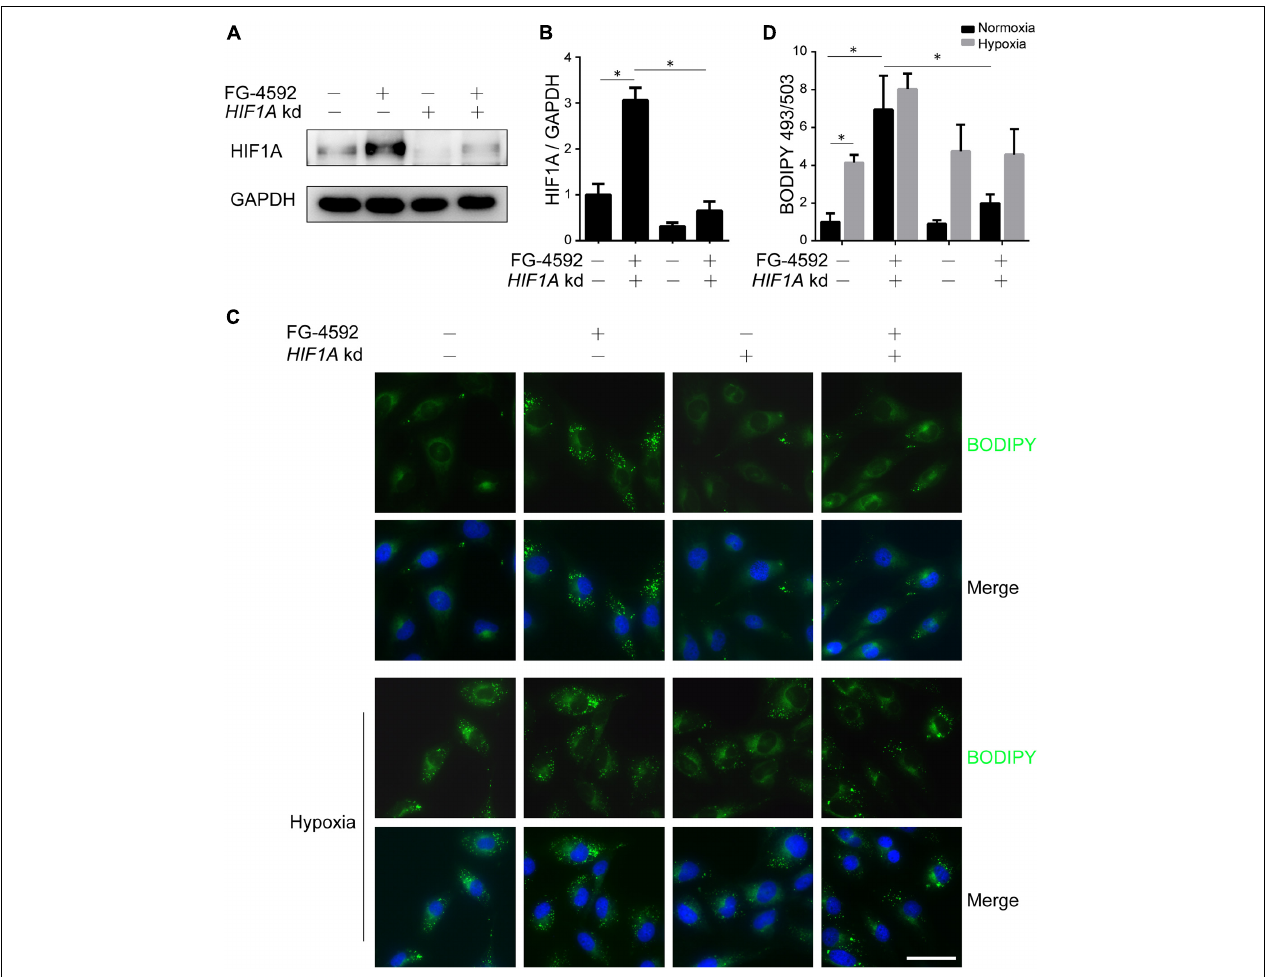
FIGURE 1 | HIF1 α activation leads to lipid accumulation in tubular cells. HK2 cells were treated or untreated with 50 µ M FG-4592 in serum-limited medium for 24 h. Representative immunoblots (A) and quantitative analysis (B) of HIF1 α in total cell lysates from HK2 cells. GAPDH was used as loading control. (C,D) Lipid droplets of HK2 cells were labeled by BODIPY 493/503 (green) staining, and the average areas of BODIPY 493/503 staining per cell were evaluated by optical density. Nuclei were stained with Hoechst 33258 (blue). Values were normalized to control group. HIF1A kd: HIF1A knockdown by siRNA. Scale bar: 50 µ m. All images are representative of multiple experiments. Statistical analysis was performed using Student’s t test. * p < 0.05. Values are expressed as the mean ±